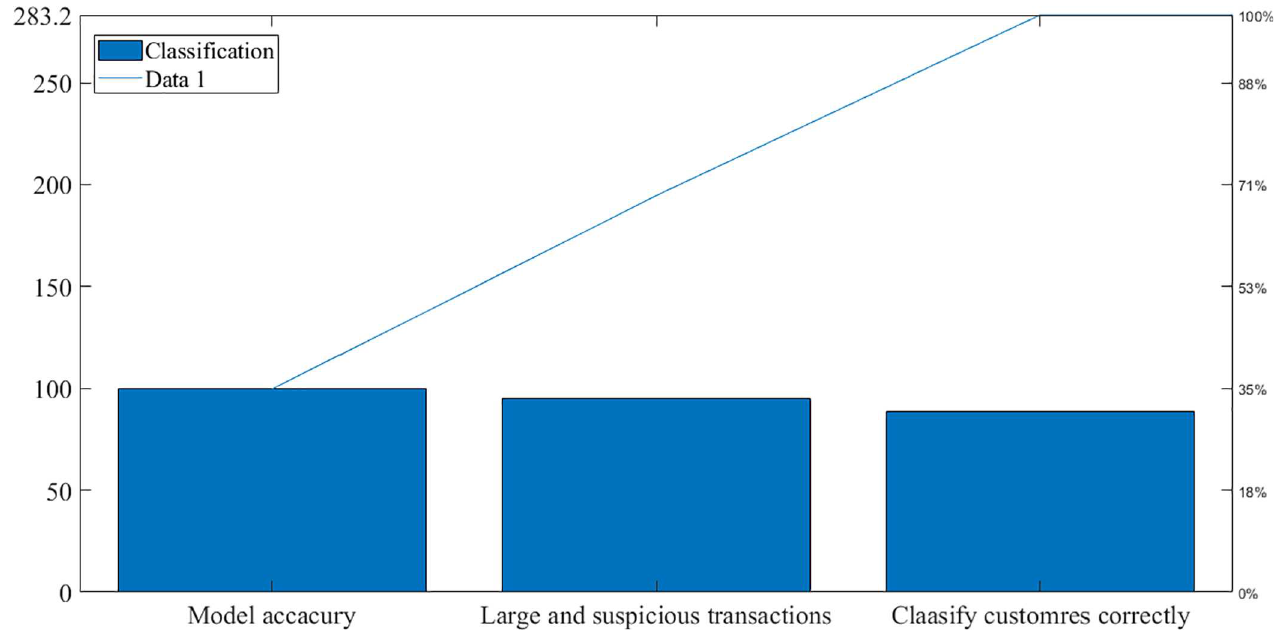
Fig 3. Percentage of target classification for each